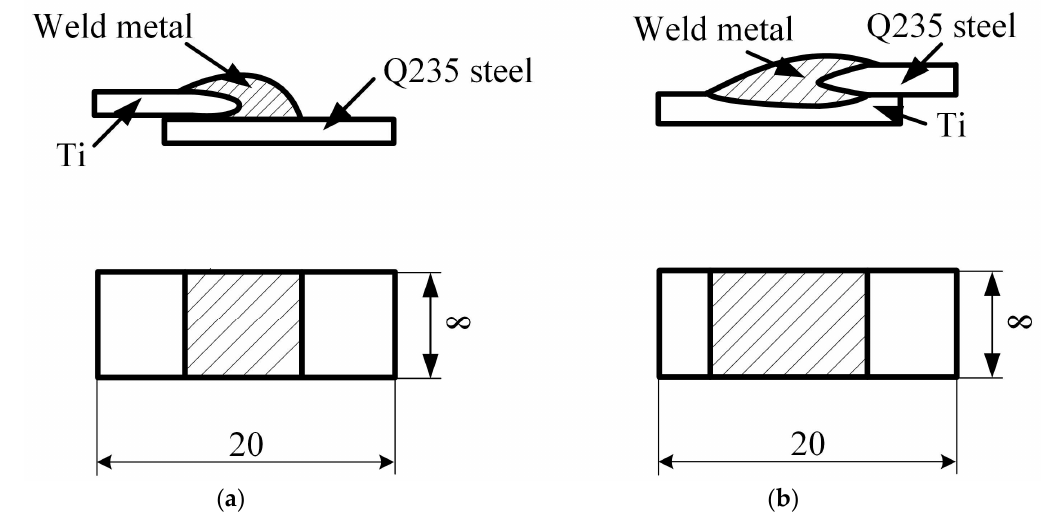
Figure 2. Dimensions (in mm) and configuration of cross-sections of the specimens: ( a ) Joint I (sample #1) and ( b ) Joint II (sample